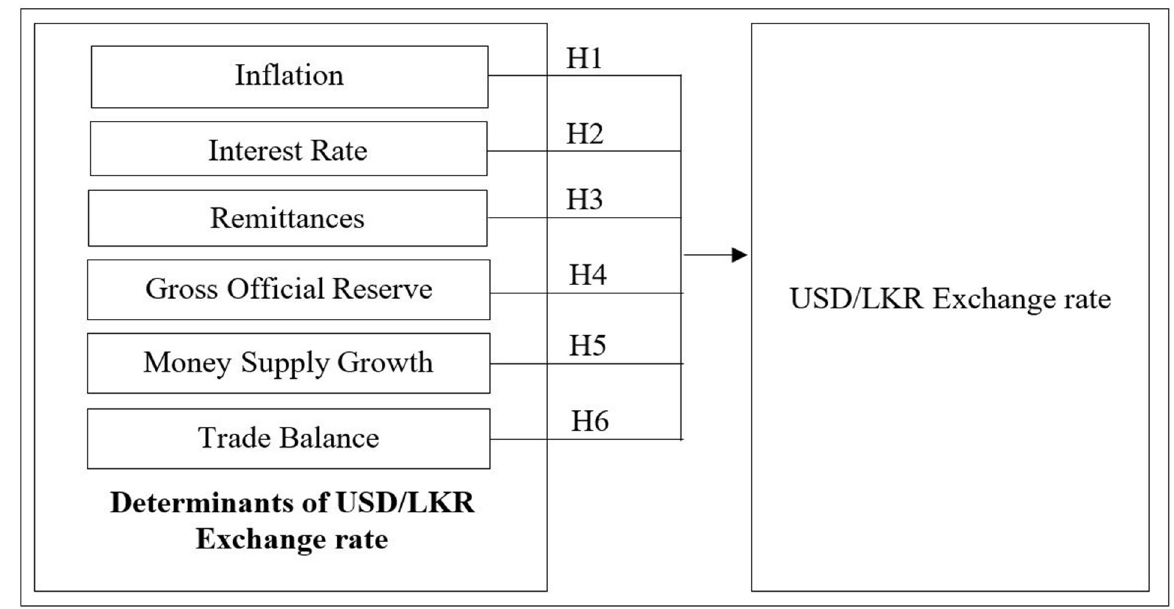
Fig 1. Conceptual framework. Source: Authors’ construct based on the reviewed literature.